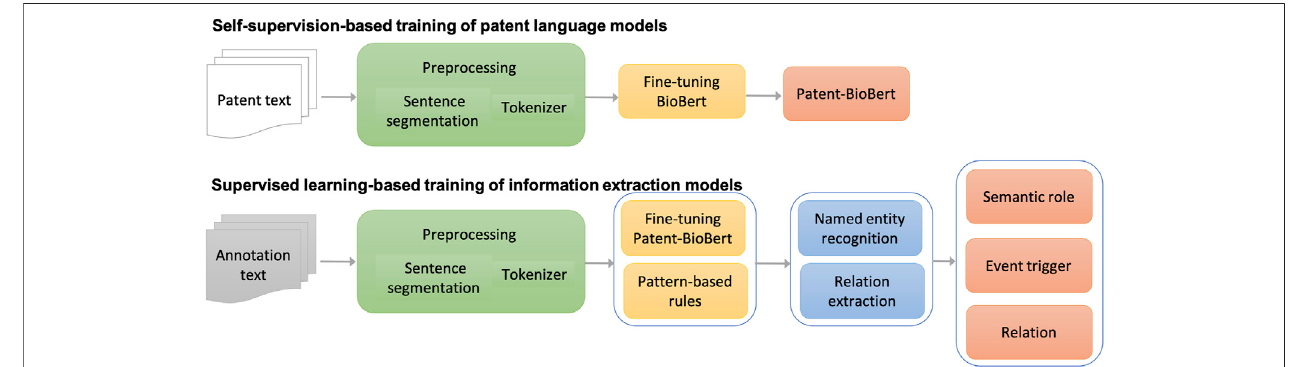
FIGURE 2 | Work fl ow of building information extraction systems for chemical reactions in